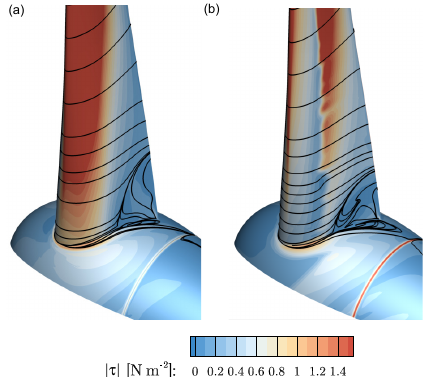
Figure B1. Surface streamlines and contours of shear stress magni- tude for fully turbulent k – ω –SST simulation (a) and γ – Re θ – k – ω – SST simulation (b) .